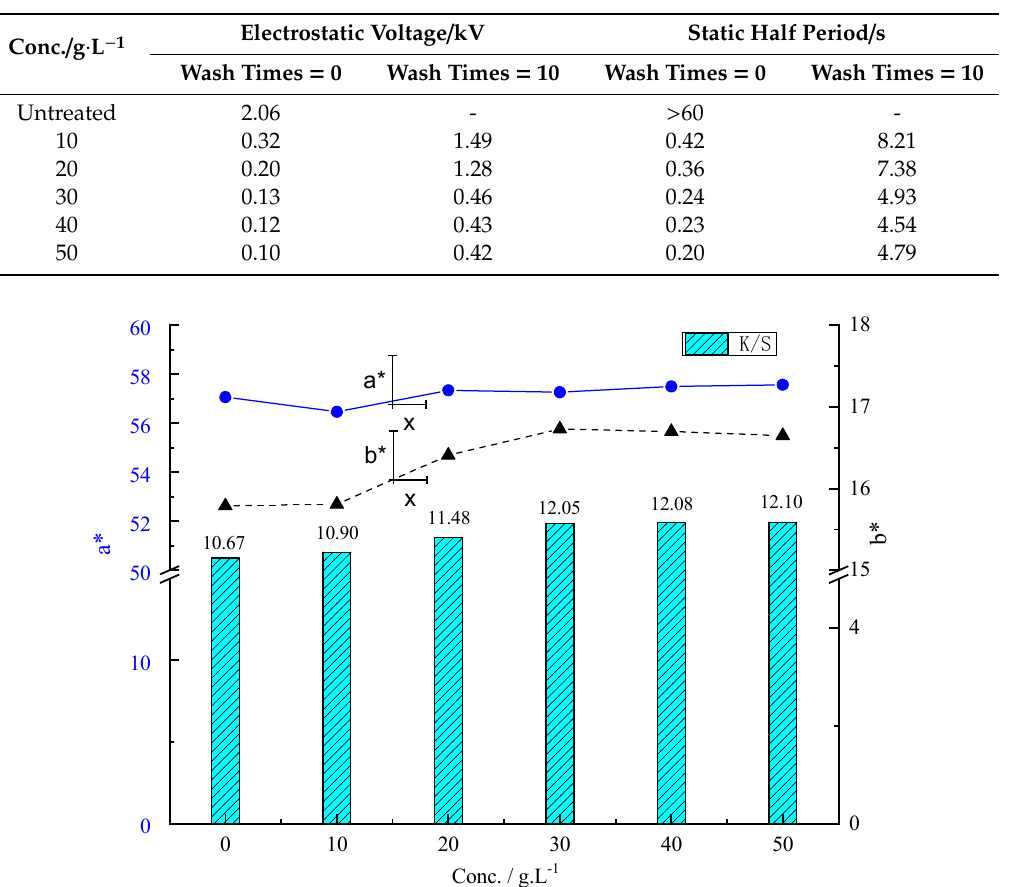
Figure 5. Effect of P[St-BA-F6] concentration on K/S, a* and b* values. Figure 5. E ff ect of P[St-BA-F6] concentration on K / S, a* and b*